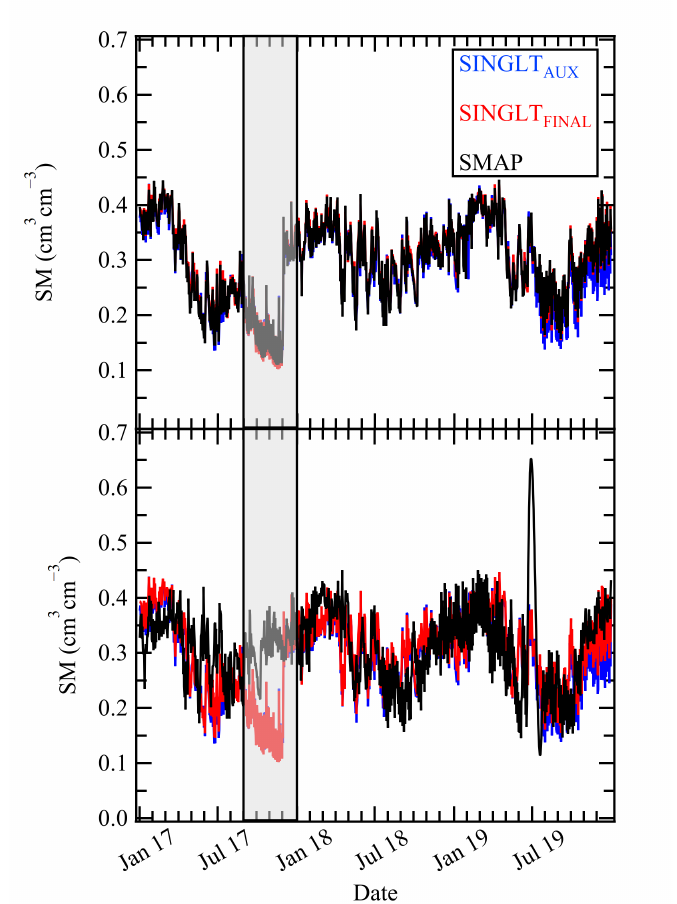
Figure 5. SNGLT_PGLNF model results for the ELKR site during the TIME_E ( top ) and TIME_P ( bottom ) periods. Results shown are for the SNGLT model evaluated on the ELKR test set. The gray box shows a severe drought observed in the late summer and fall of 2016 that was falsely predicted during the TIME_P period, indicating overfitting to the training